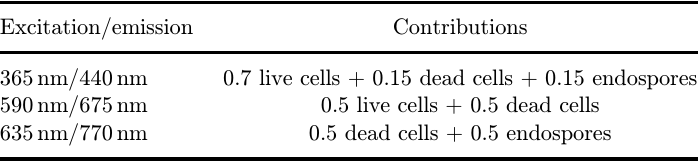
Table 1. Fluorescence channels: Bacterial cell contributions.